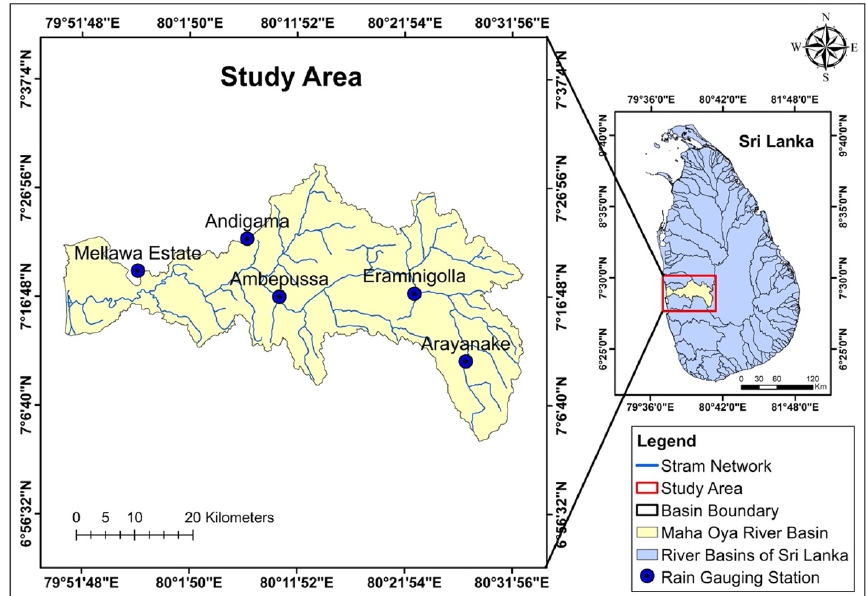
Figure 1. Study area location map of Maha Oya River Basin with rain gauging stations. Table 1. Location of rain gauging stations in Maha Oya River Basin.